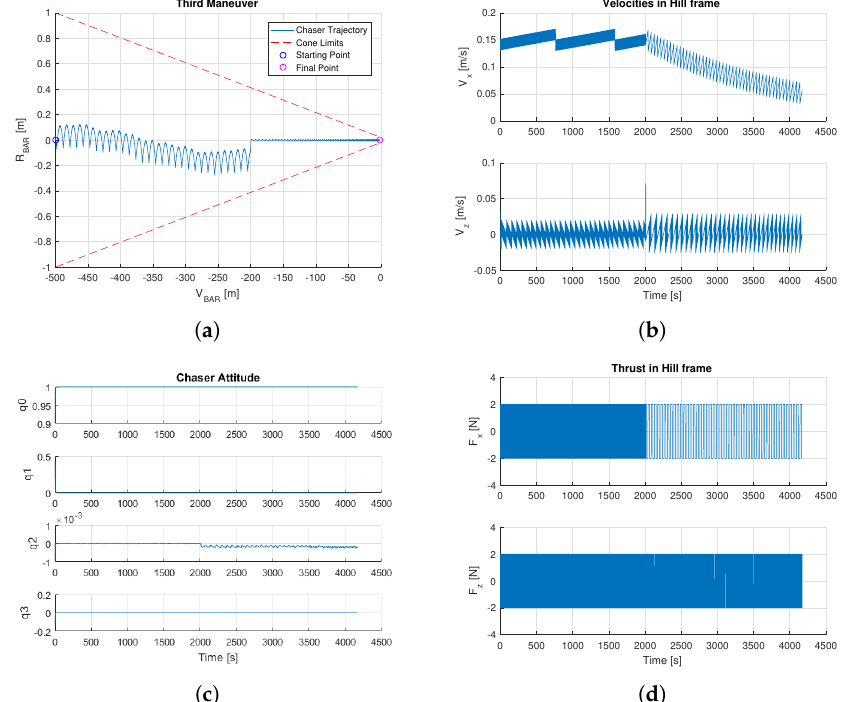
Figure 9. Third maneuver highlights for the SMC controller. ( a ) Third Maneuver: V BAR − R BAR plane. ( b ) Relative velocity. ( c ) Relative quaternion. ( d ) Thrust